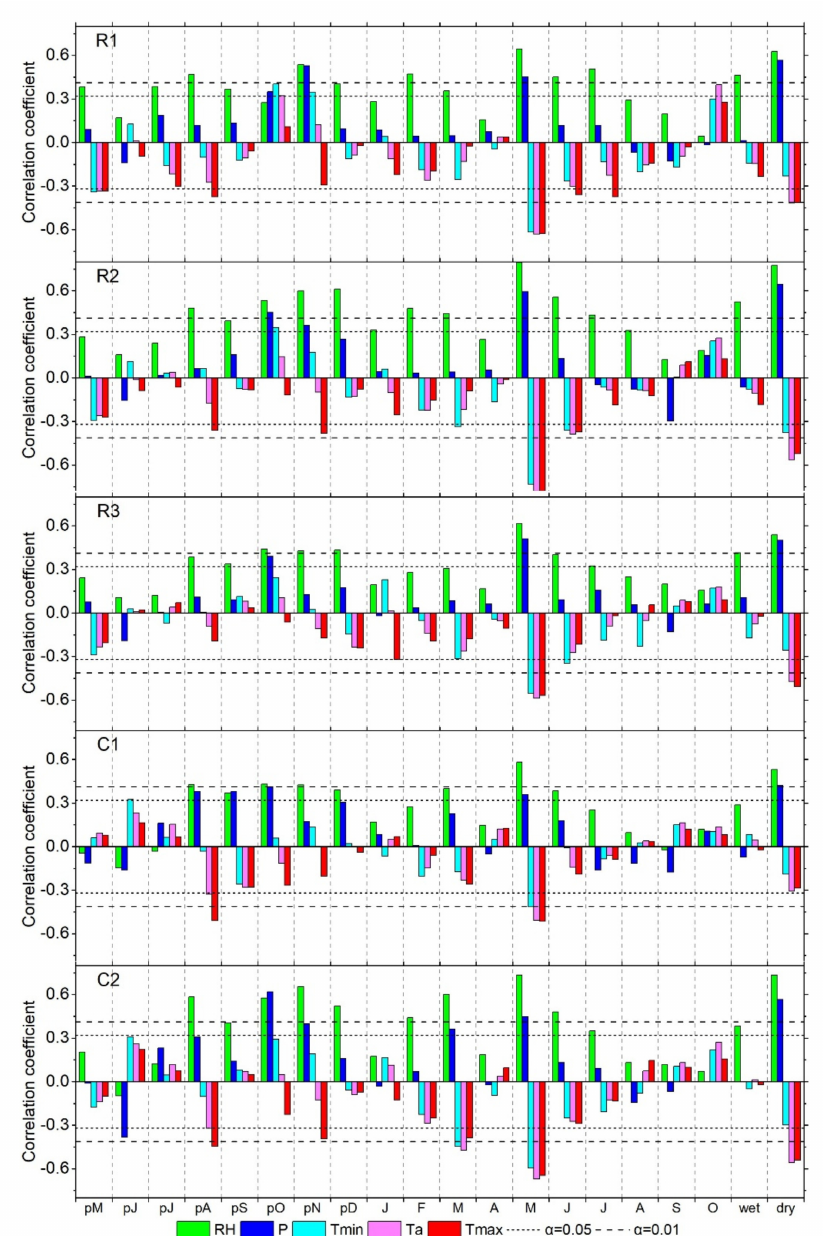
Figure 3. Correlation coe ffi cients between chronologies and meteorological data. α is the threshold of the significance level. Here are shown the results of the raw series and the first di ff erence series can be referred to Figure